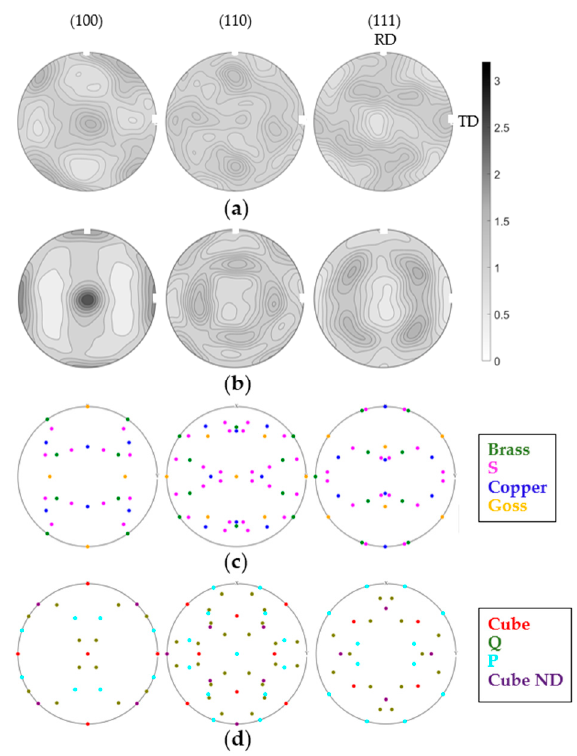
Figure 1. Typical textures of annealed ( a ) EN AW-5182 and ( b ) EN AW-6016; ideal orientations of main ( c ) rolling texture components and ( d ) recrystallization texture components. RD, rolling direction; TD, transverse direction; ND, normal direction.